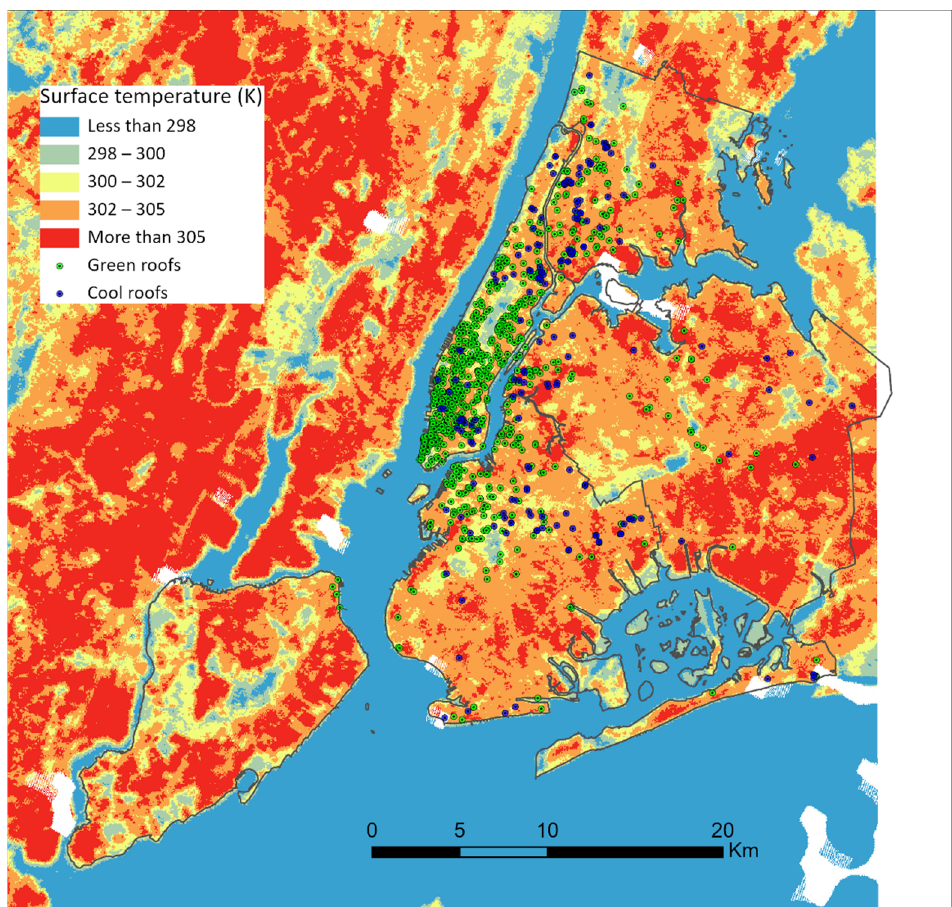
Figure 10. Maps showing surface temperature (K) measured by ECOSTRESS [28] at 70 m spatial resolution on 27 August 2020. The building locations with cool roofs in 2012 and green roofs in 2016 in New York City.